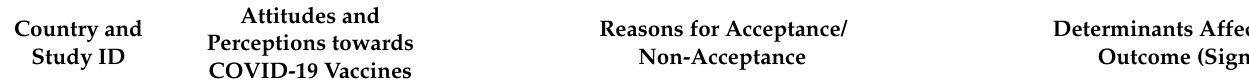
Table 3. Predictors of COVID-19 vaccine uptake among the general population in